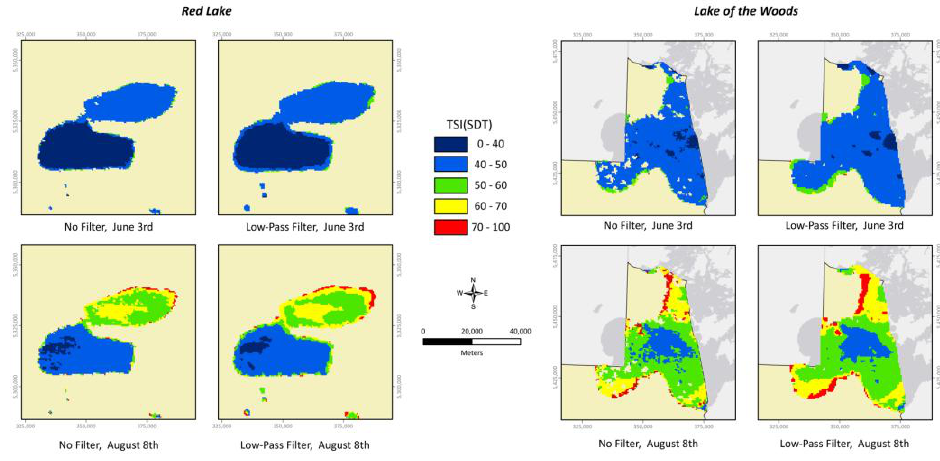
Figure 2. Within-lake TSI variation, with and without low-pass filtering to smooth out (SDT) variability in the maps. This image series includes examples from two of Minnesota’s largest lakes in MODIS images early in the growing season when lakes exhibit maximum clarity and later in the summer when lake clarity is at its seasonal low.